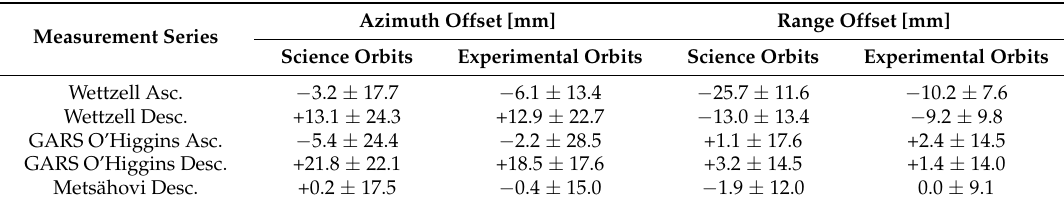
Figure 10. Comparison of the mean values ( a ) and standard deviations ( b ) in azimuth and range for operational Science orbits (values of Table 6) and new experimental orbits (values of Table 9). The different colors represent the different measurement series. Table 9. Comparison of the mean values and standard deviations in azimuth and range for operational Science orbits (as they are already shown in Table 6) and for the new experimental TerraSAR-X orbit solutions discussed in [28] (operationally not accessible as yet).